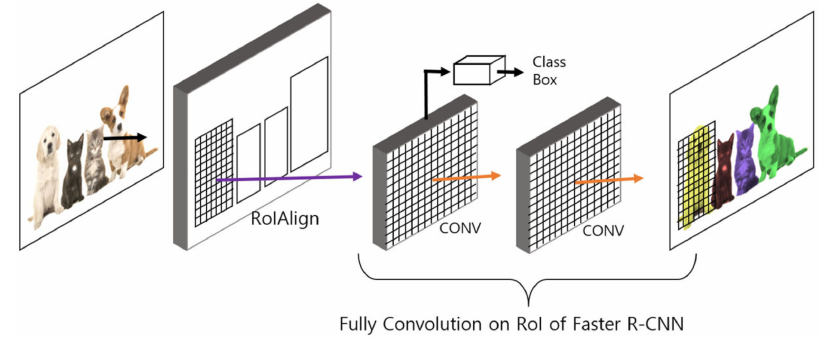
Figure 6. Mask R-CNN